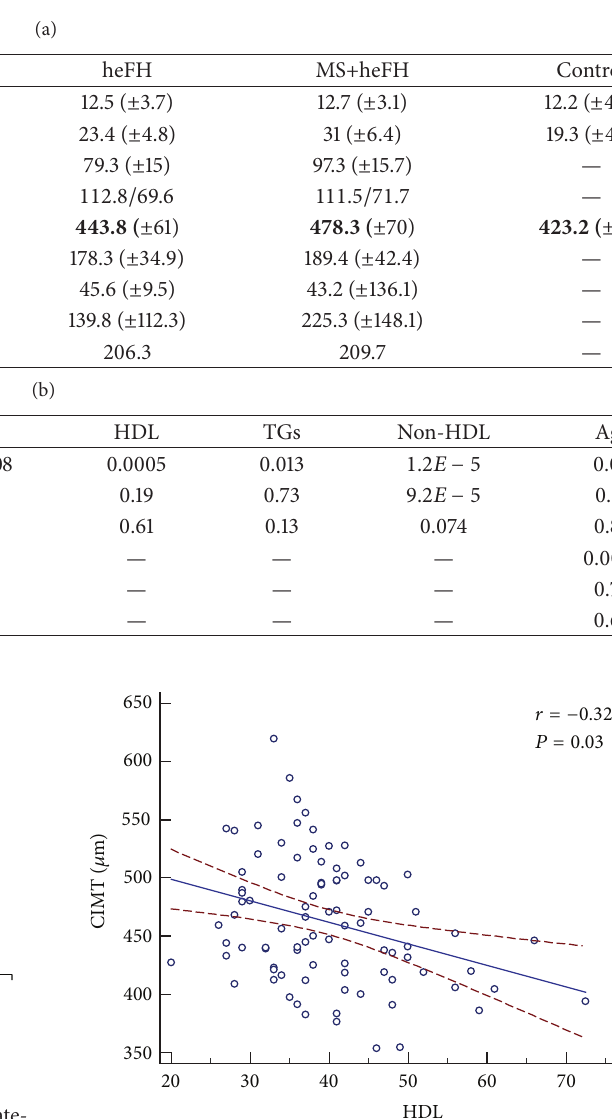
Table 1: (a) Patient characteristics, CIMT, and lipid variables. (b) 𝑃 values for measurements in Table 1(a).